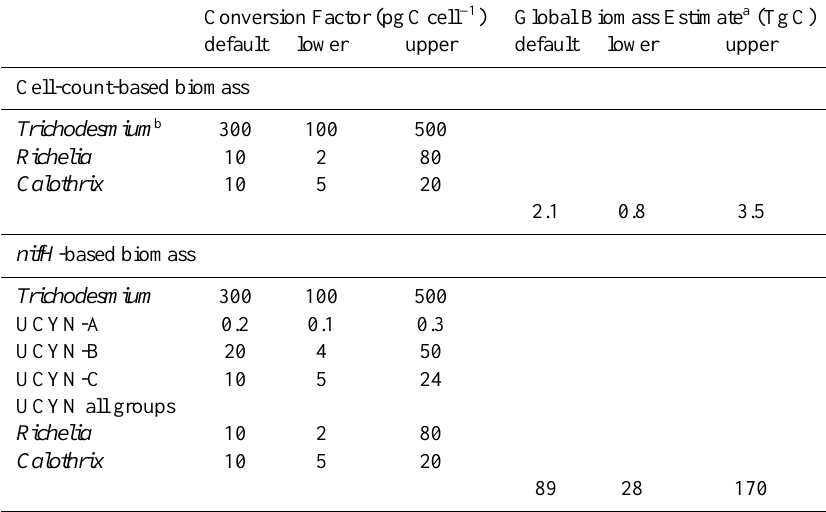
Table 2. Estimated default and the upper and lower bounds for the biomass conversion factors, and their impacts on global biomass estimates (based on geometric